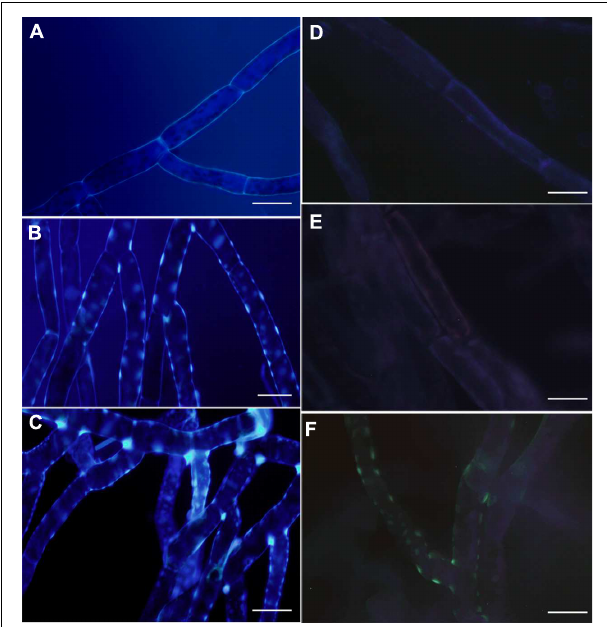
FIGURE 6 | Cell wall associated modification in overexpressing PpPR-10 P. patens protonemal tissues. Untreated protonemal tissues of wild type (A) , pUBI:PpPR-10-1 (B) , and pUBI:PR-10-3 (C) stained with solophenyl flavine. Untreated protonemal tissues stained with methyl blue showing callose deposition in wild type (D) , pUBI:PpPR-10-1 (E) , and pUBI:PR-10-3 (F) . The scale bars represent 20 µ